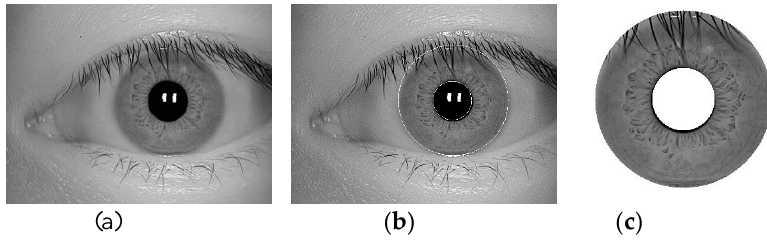
Figure 15. The image of each stage of positioning. (a) Quality qualified image, ( b ) positioning image, ( c ) segmentation image.